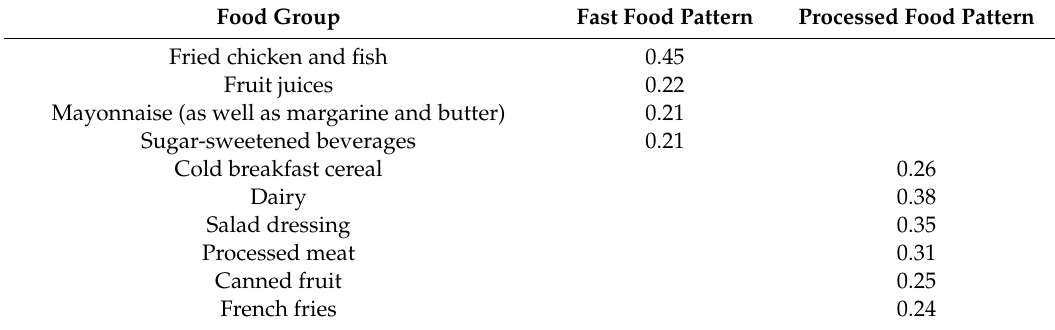
Table 1. Factor loadings of major food groups associated with the fast food and processed food patterns a . Food Group Fast Food Pattern Processed Food Pattern Fried chicken and fish 0.45 Fruit juices 0.22 Mayonnaise (as well as margarine and butter) 0.21